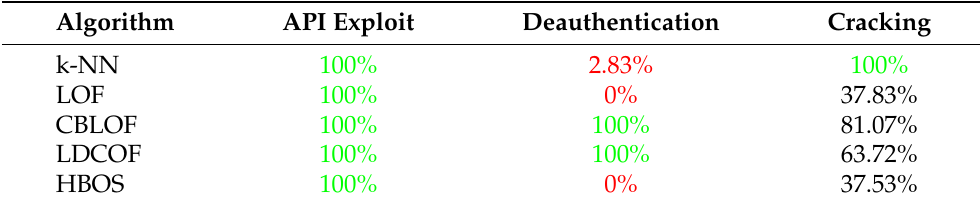
Table 5. Hit rates of anomaly detection